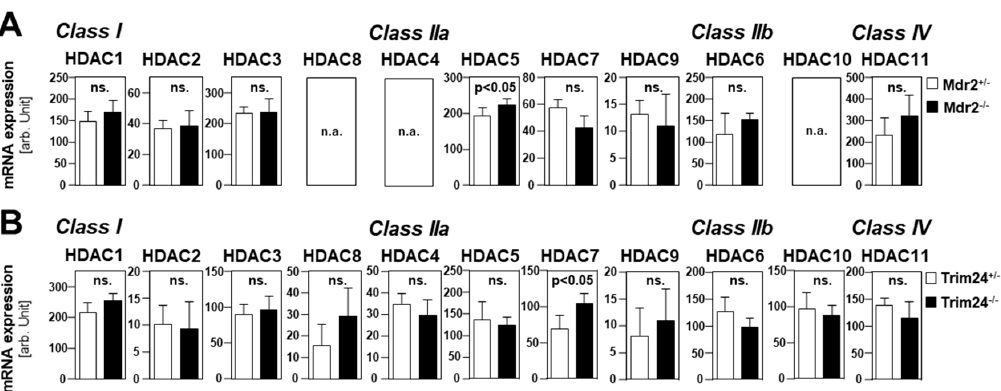
Figure 3. HDAC expression levels in genetically induced murine HCC models. ( A , B ) In silico analysis of mRNA expression levels for different HDACs was performed using GEO/GSE datasets (https://www.ncbi.nlm.nih.gov/geoprofiles). ( A ) RNA expression levels in pre-cancerous stages in the murine Mdr2 knockout HCC model in heterozygous ((Mdr +/- , n = 6) and homozygous (Mdr -/- , n = 6) knockouts (* p < 0.05 vs hetero). ( B ) RNA expression levels in livers from wild-type (ctrl, n = 5) as compared to HCC tumors (HCC, n = 5) derived from the Trim24-deficient spontaneous murine HCC model (ns: non-significant vs ctrl; * p < 0.05 vs ctrl).